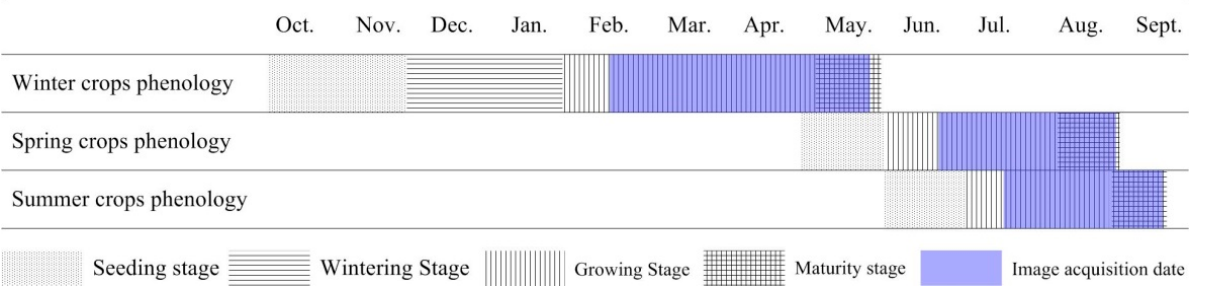
Figure 2. Crop phenology and image acquisition date.